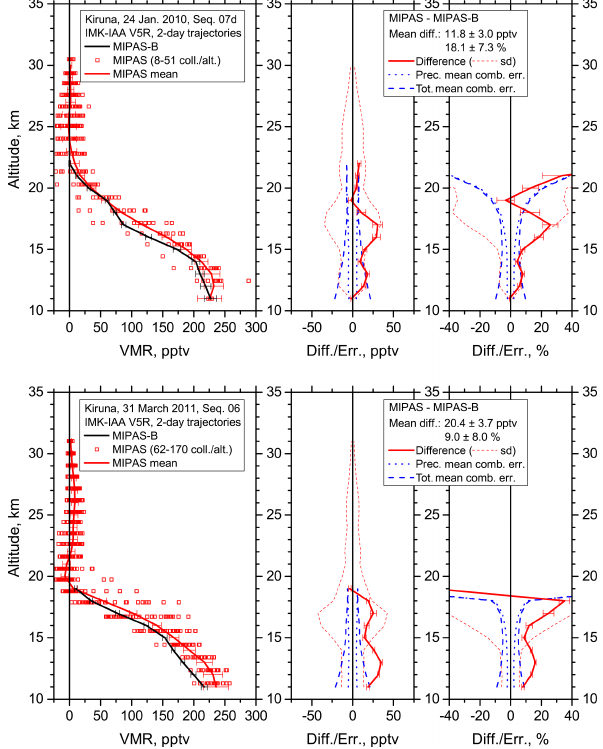
Figure 4. Comparison of a mean profile of MIPAS CFC-11 col- located measurements (left panels: red line) with a profile of MIPAS-B (black line) obtained on 24 January 2010 (upper panels) and 31 March 2011 (lower panels) at Kiruna. The error bars (1 σ ; left panel) show the total error without the spectroscopy error for MIPAS and MIPAS-B. The difference is shown in absolute (middle panels) and relative (right panels) terms. The dotted red line is the standard deviation and the dashed blue line is the combined error which consists of the root of the squared error of MIPAS-B and the MIPAS